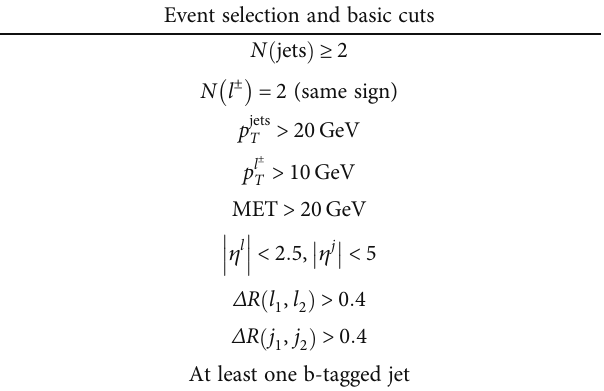
Table 4: List of basic